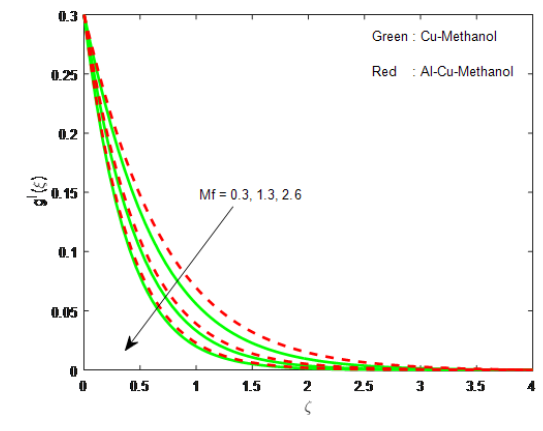
Fig. 15: Impression of Mf on g (cid:48) ( ξ )